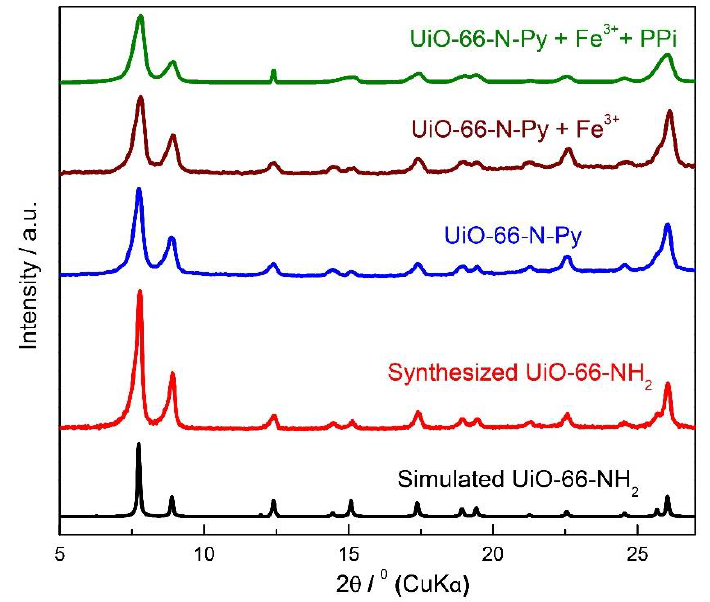
Figure 2. Powered XRD patterns of UiO-66-NH 2 obtained from cif file, UiO-66-NH 2 as synthesized, UiO-66-N-Py as synthesized, UiO-66-N-Py after addition of iron, and UiO-66-N-Py + Fe 3+ after addition of pyrophosphate (PPi).